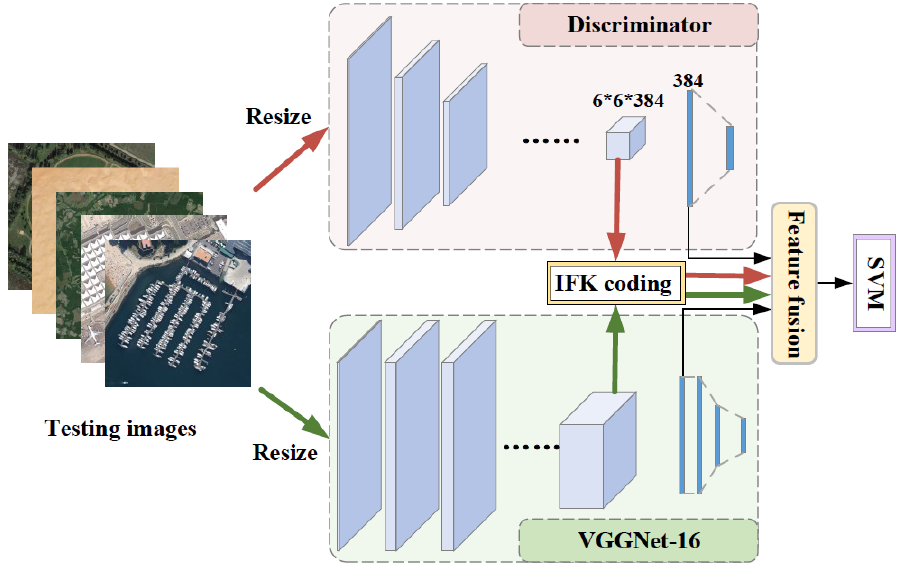
Figure 2. The flowchart of the proposed scene classification based on